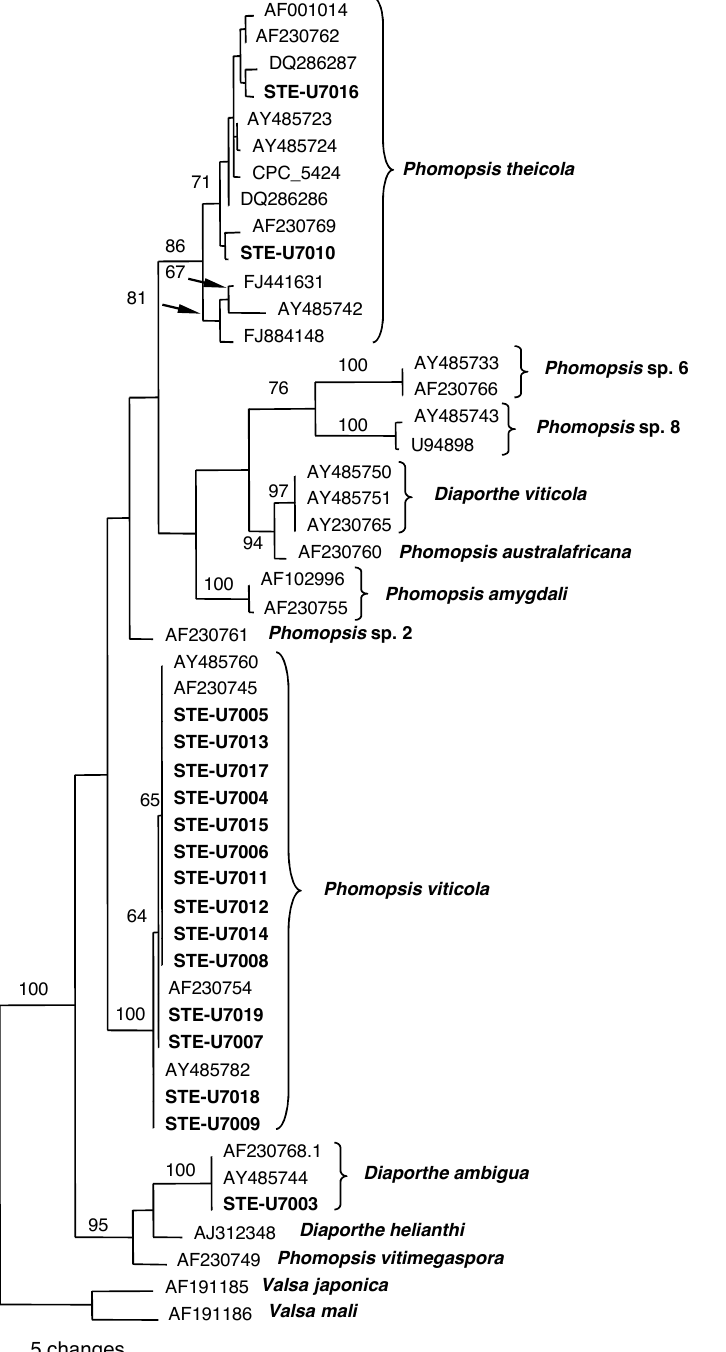
Figure 2. One of 22 most parsimonious trees obtained from heuristic searches of the ITS sequences (length: 325 steps; CI: 0.578; RI: 0.847; RC: 0.490) of Phomopsis isolates. Bootstrap support values above 60% are shown above the nodes. The outgroups used were Valsa japonica and Valsa mali . Isolates in bold print are from this